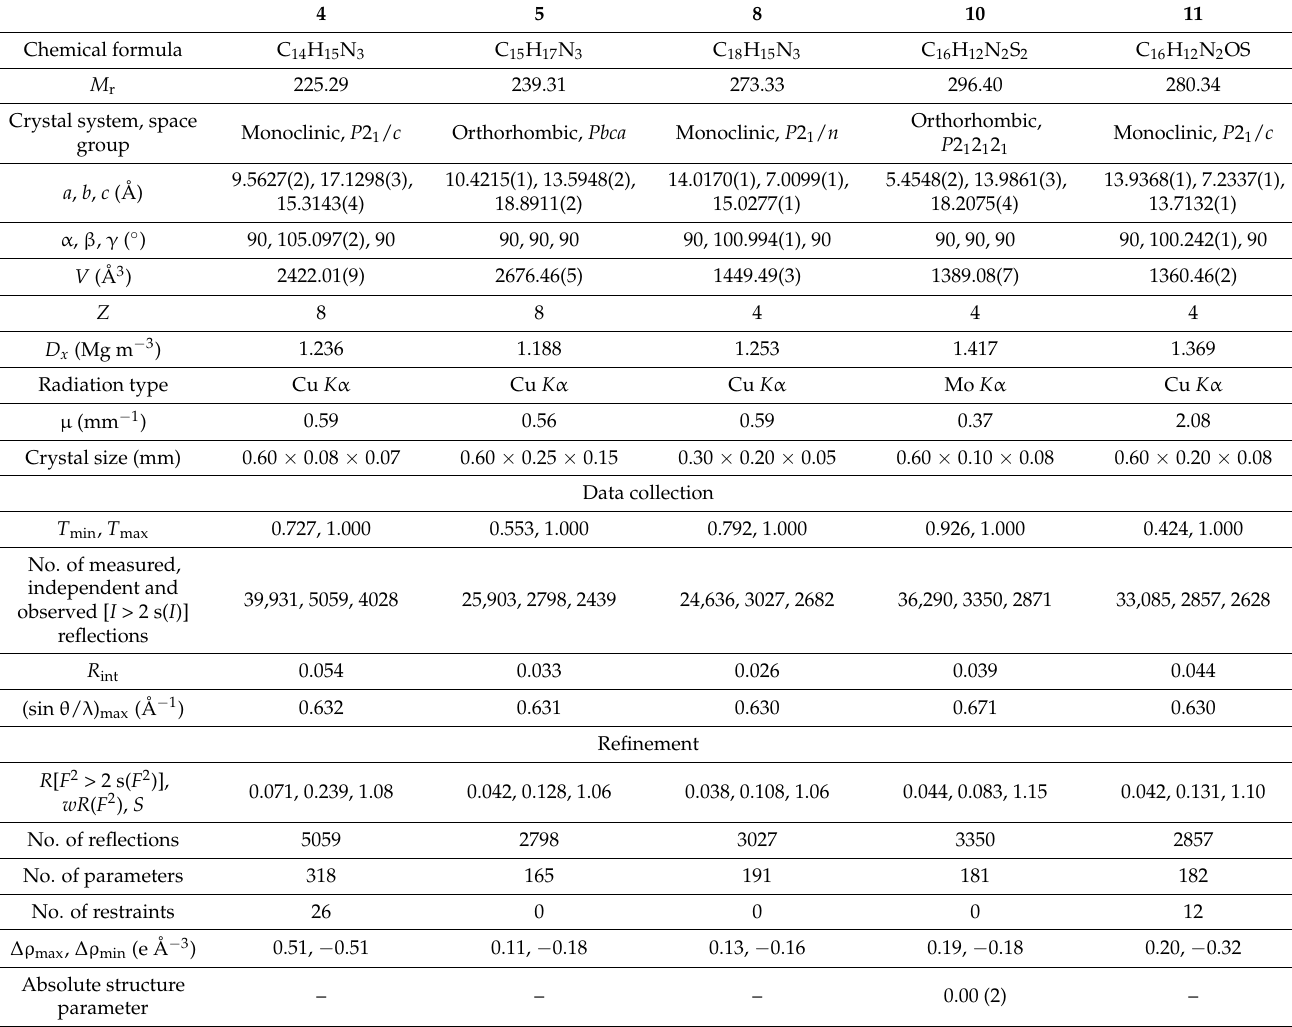
Table 7. Crystal data and structure refinement parameters for selected gramine